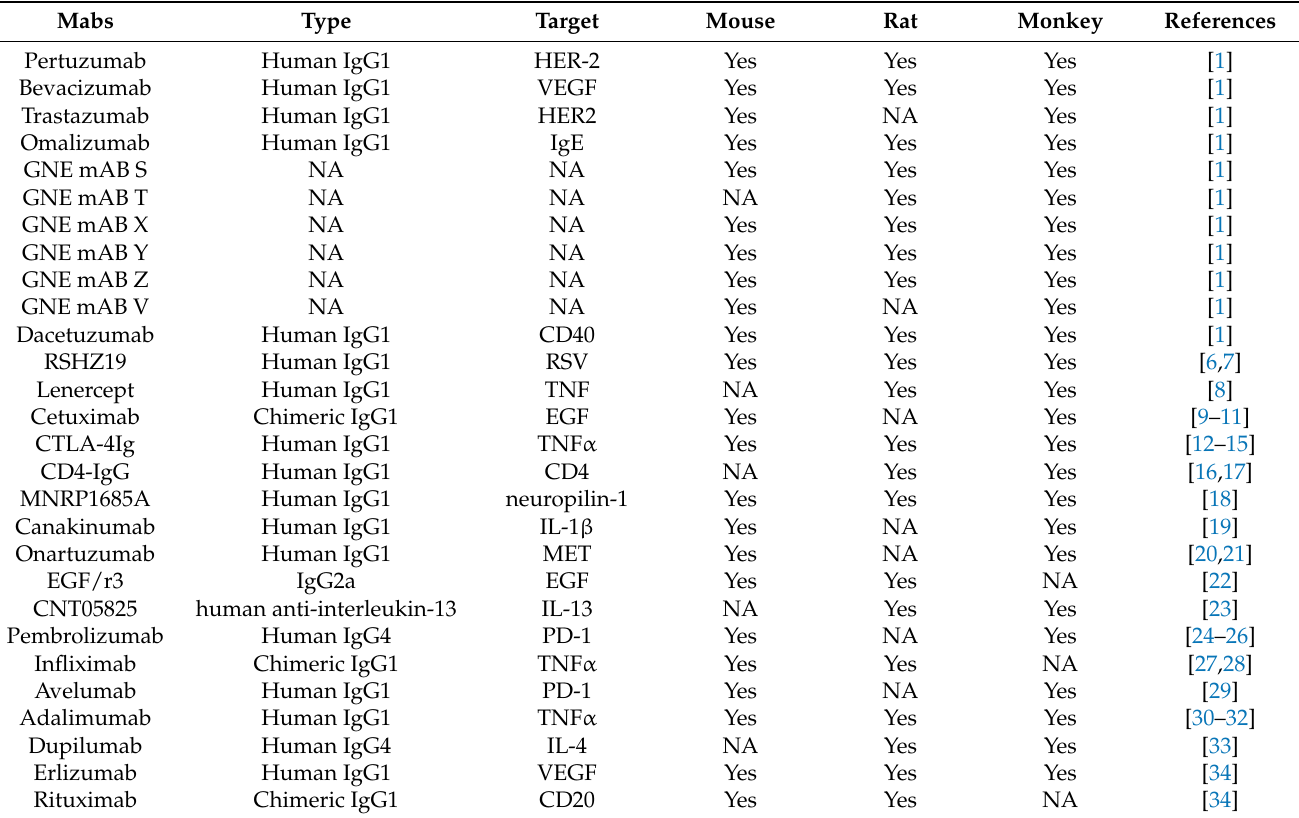
Table 1. Name of the mabs used in the analysis.